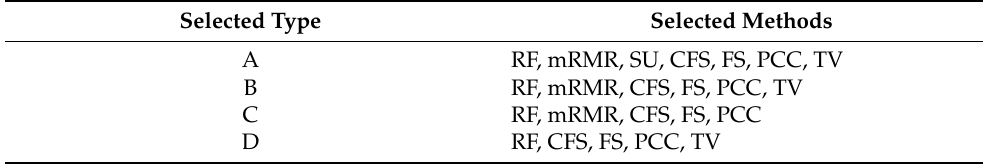
Table 2. Feature selection ranking collection. Selected